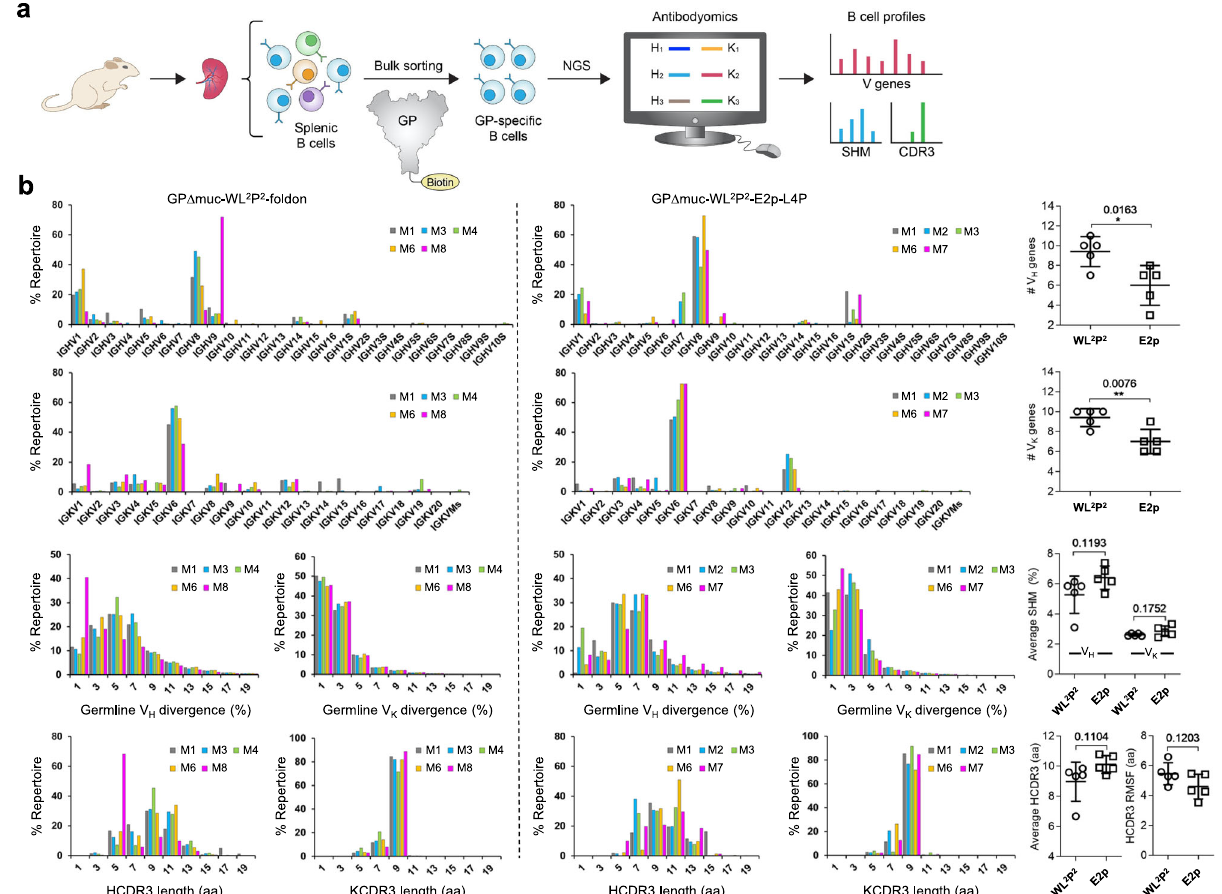
Fig. 6 Quantitative assessment of GP-speci fi c B-cell response. a Schematic representation of the strategy to analyze the GP-speci fi c murine B-cell response that combines the antigen-speci fi c bulk sorting of splenic B cells with next-generation sequencing (NGS) and antibodyomics analysis. b B-cell pro fi les for the GP Δ Muc-WL 2 P 2 -foldon (left) and GP Δ Muc-WL 2 P 2 -E2p-L4P groups (right) and statistical comparison of key parameters derived from the pro fi le analysis (far right). For each vaccine group ( n = 8), fi ve mice were selected for NGS analysis. Panel 1/2: Distribution of germline V H /V K genes and statistical comparison of the number of activated V H /V K genes ( ≥ 1% of the total population). Panel 3: distribution of V H /V K somatic hypermutation (SHM) with percent (%) mutation calculated at the nucleotide level, and statistical comparison of the average V H /V K SHM rate. Panel 4: distribution of H/KCDR3 loop length and statistical comparison of two parameters, HCDR3 loop length and root-mean-square fl uctuation (RMSF) of HCDR3 loop length. The RMSF value is used as an indicator of how much HCDR3 loop length varies within the EBOV GP-speci fi c antibodies from each animal. In statistical comparison (far right), mean value and standard deviation (SD) are shown as black lines. P values were determined by an unpaired two-tailed t test in GraphPad Prism 8.4.3 and are labeled on the plots. The asterisk symbol (*) indicates the level of statistical signi fi cance: * P < 0.05; ** P < 0.01; *** P < 0.001. Source data are provided as a Source Data